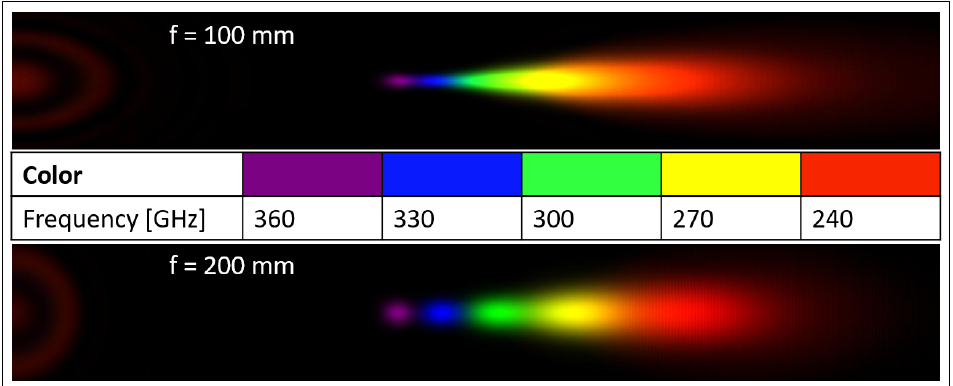
Figure 2. Calculated positions of the focal spots for structures with the focal lengths f = 100 mm ( top ) and f = 200 mm ( bottom ). Intensity distributions are shown with a main optical axis in the middle of left edge of the illustrated area. Colors denote the frequency of the illuminating radiation as in the